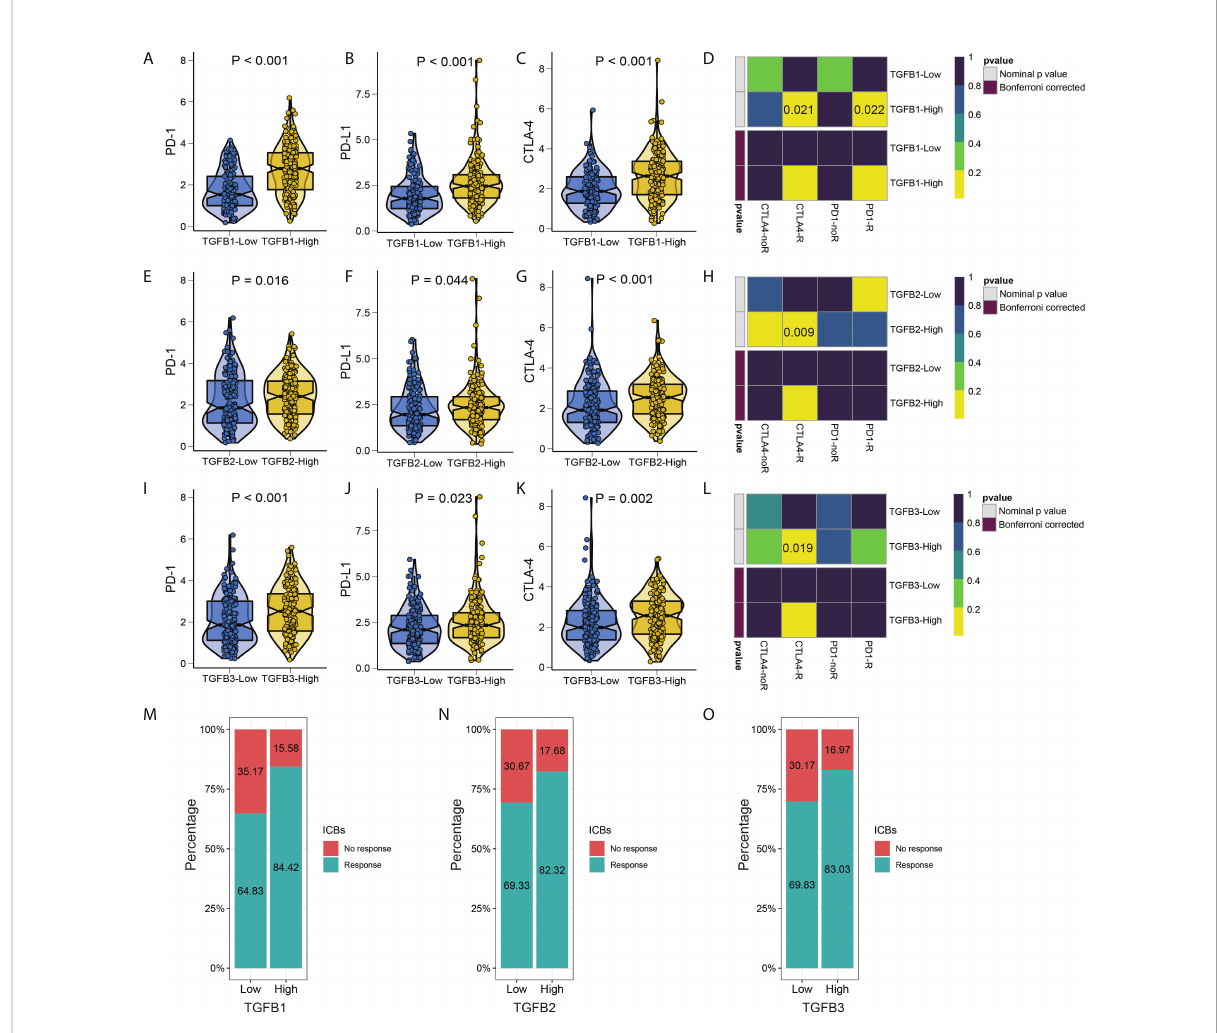
FIGURE 10 TGF b and immunotherapy. Differences in PD – 1, PD – L1 and CTLA – 4 immune checkpoints between different TGF b 1 (A – C) , TGF b 2 (E – G) and TGF b 3 (I – K) groups. Heatmap visualized the response to anti – CTLA4 and anti – PD1 therapies between different TGF b 1 (D) , TGF b 2 (H) and TGF b 3 (L) groups. (M – O) The histogram showed the responsiveness of immunotherapy between high and low TGF b groups, the height of each bar represents the frequency of